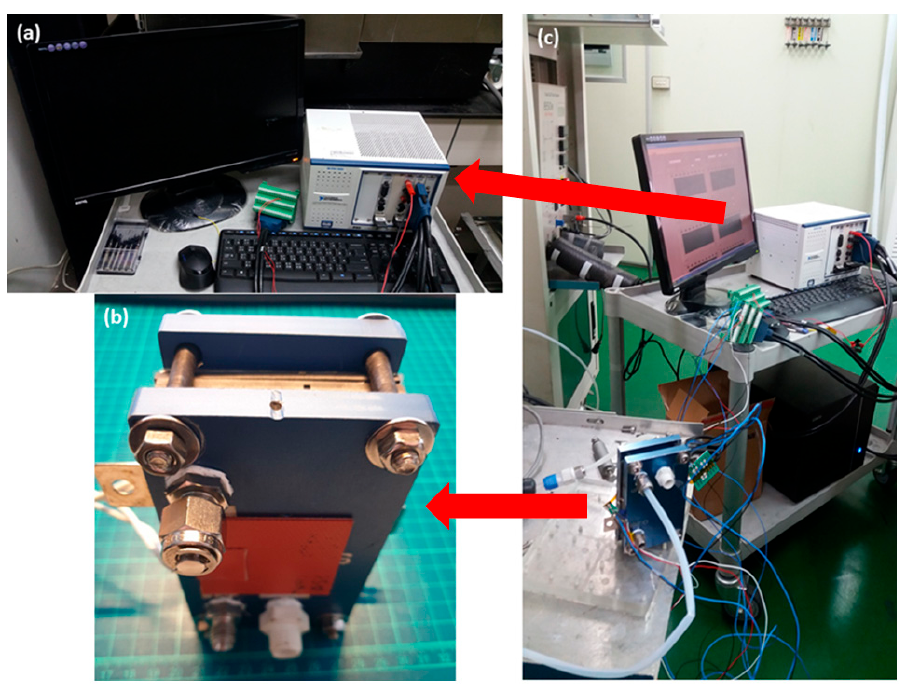
Figure 3. ( a ) National Instruments (NI). ( b ) Fuel cell testing machine. ( c ) The micro hydrogen sensor is tested and calibrated.